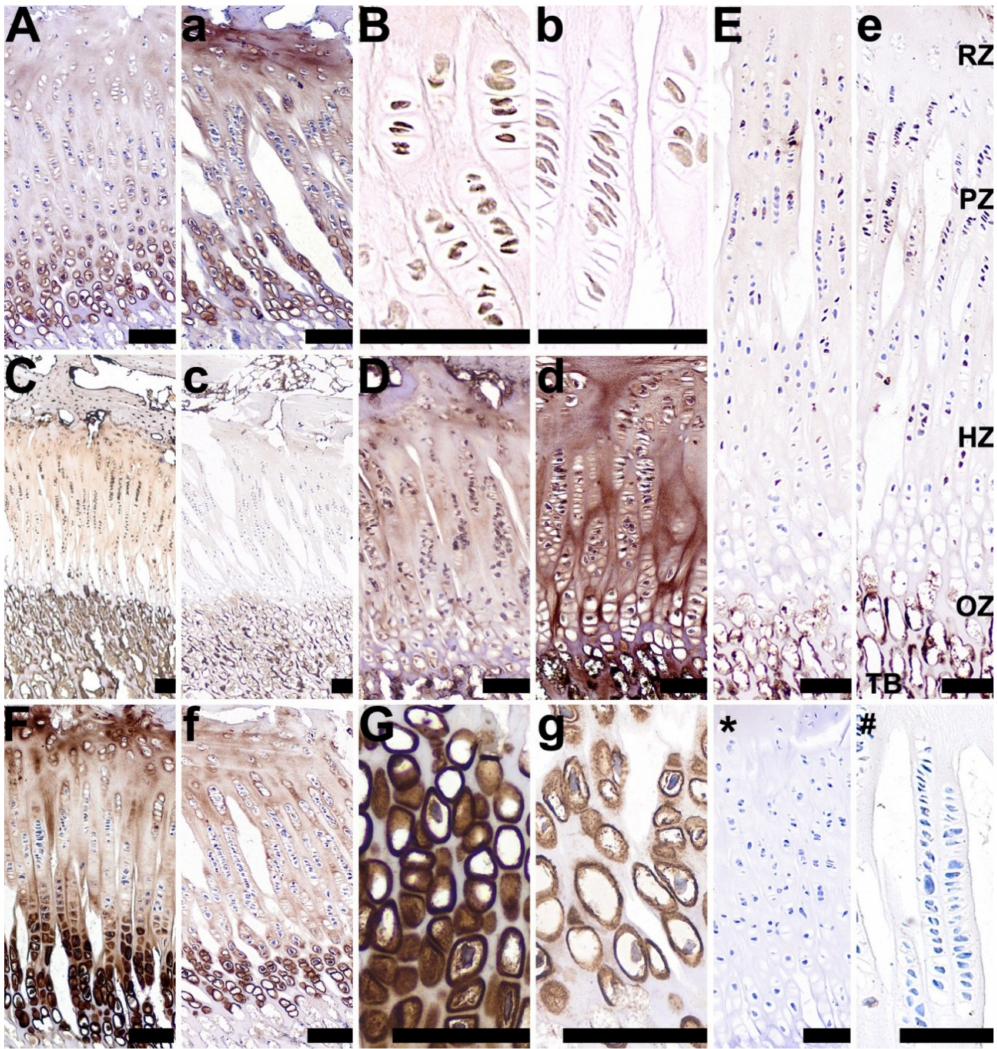
Figure 8. Representative pictures of the immunohistochemical analysis of bone morphogenetic protein 2, BMP-2 ( A , a ); glucocorticoid receptors, GRs ( B , b ); receptor activator of nuclear factor kappa-B ligand, RANKL ( C , c ); tissue inhibitor of metalloproteinases 2, TIMP-2 ( D , d ); osteoprotegerin, OPG ( E , e ); and vascular endothelial growth factor, VEGF ( F , f , G , g ), carried out on formaldehyde-fixed sections from the femoral growth plate cartilage in the control group (growth-retarded gilts not supplemented with 2-Ox ( A – G )) and the 2-Ox group (growth-retarded gilts supplemented with 2-Ox at a dose of 0.4 g / kg b.w. / day ( a – g )). Negative protein expression is represented by blue staining of the cytoplasm in the chondrocytes, while positive protein expression is represented by brown staining in the cells. Additionally, proteins (BMP-2, OC, RANKL, VEGF) secreted and released into the matrix are also stained in a brown color. (*,#)—anti-body control reaction. In ( e ), the zones of the articular cartilage are labeled as follows: reserve zone ( RZ ), proliferation zone ( PZ ), hypertrophy zone ( HZ ), and ossification zone ( OE ), as well as trabecular bone ( TB ). Each scale bar shows 50 µ